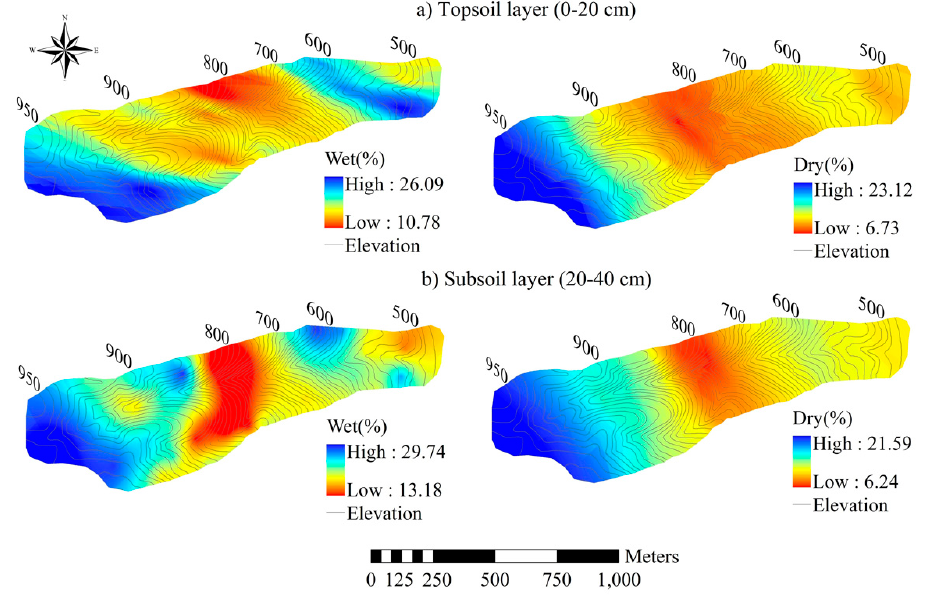
Figure 5. Spatial distributions of soil moisture in the top ‐ and subsoil layers in Laozhai catchment.